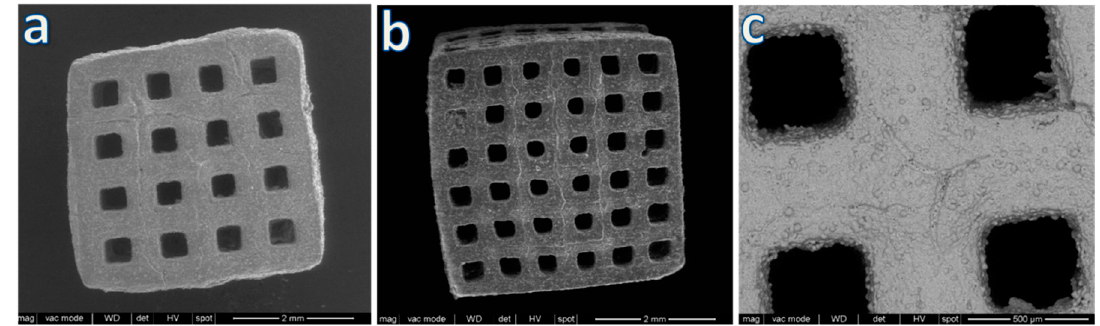
Figure 4. Microstructural details of samples from cubic cell design: ( a ) 4 cells per side; ( b ) 6 cells per side; ( c ) crack healing by viscous flow.